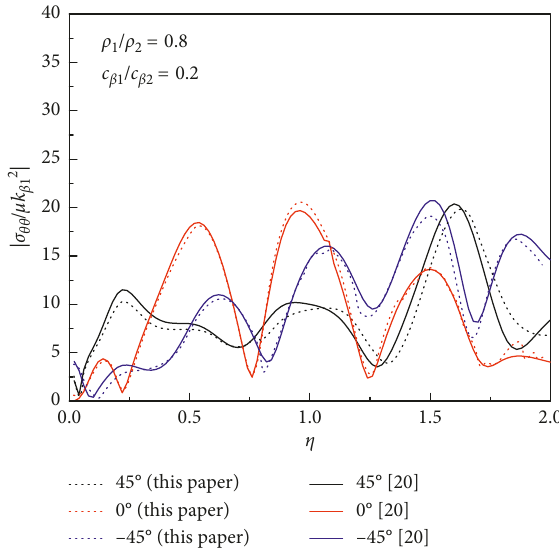
Figure 2: DSCF spectrum distribution on the inner lining wall